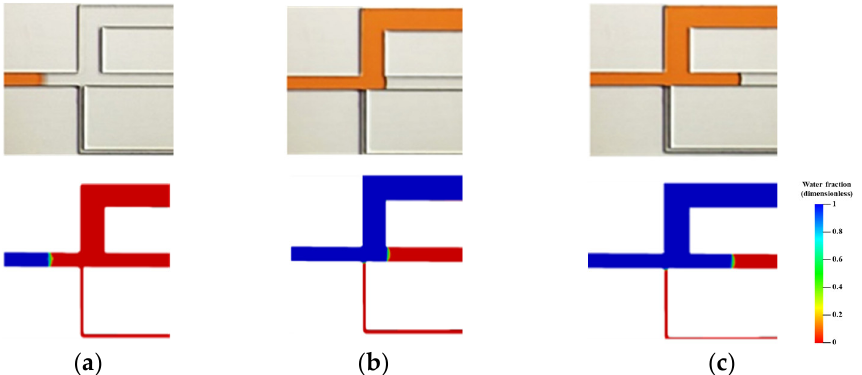
Figure 5. Comparison of the simulation with experimental results for water invasion into fork- shaped adjacent channel model at time steps of ( a ) 10 s; ( b ) 30 s; ( c ) 40 s. The upper and lower rows are experimental and simulation results, respectively. The water and gas phases are in orange and white, respectively, for the experiment results in the upper row.